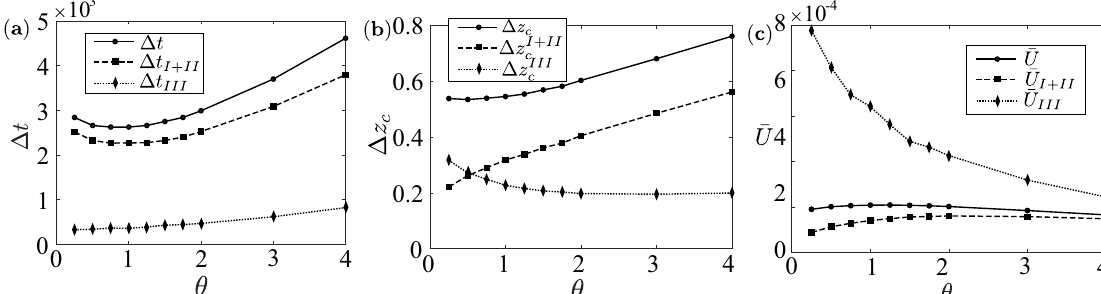
Figure 5. Relevance of the two phases over one bubble cycle: ( a ) Bubble cycle duration ∆ t and duration of first and second phase ∆ t I + II and third phase ∆ t III , respectively; ( b ) Cone displacement over one bubble cycle ∆ z c , cone displacement over the first and second phase ∆ z I + II c and third phase ∆ z III c ; ( c ) Micro-rocket average velocity over one bubble cycle ¯ U , average velocity over the first and second phase ¯ U I + II and third phase ¯ U III .